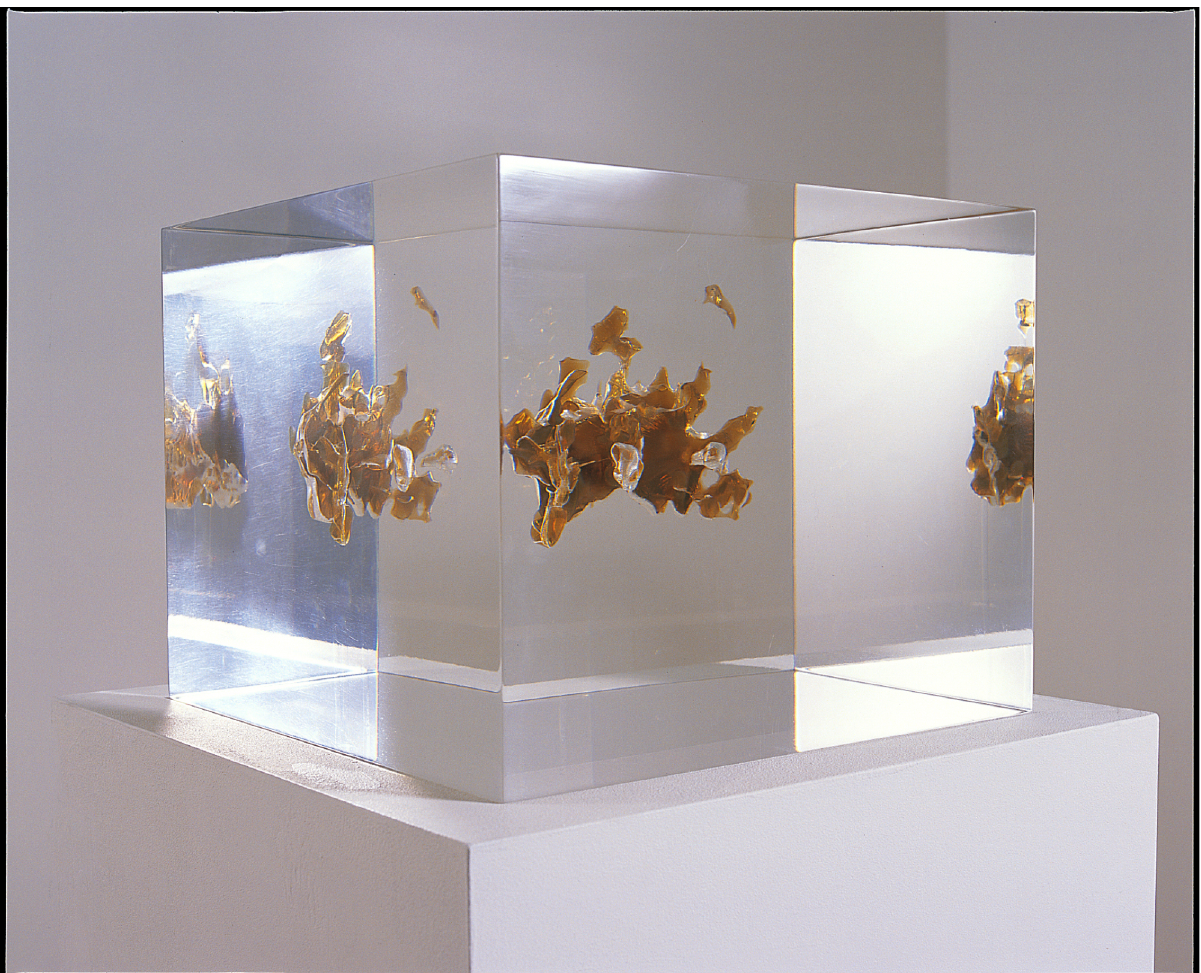
Figure 5 | Annie Cattrell, Sense-Seeing, 2002. Courtesy of the